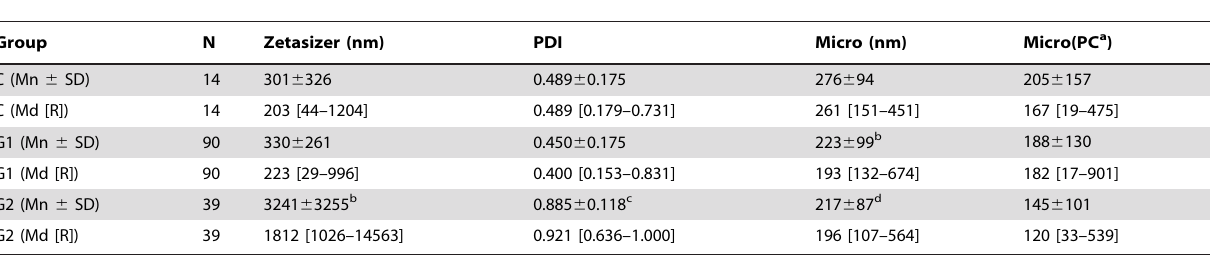
Table 2. Average Particle Size for Solutions without Precipitation.